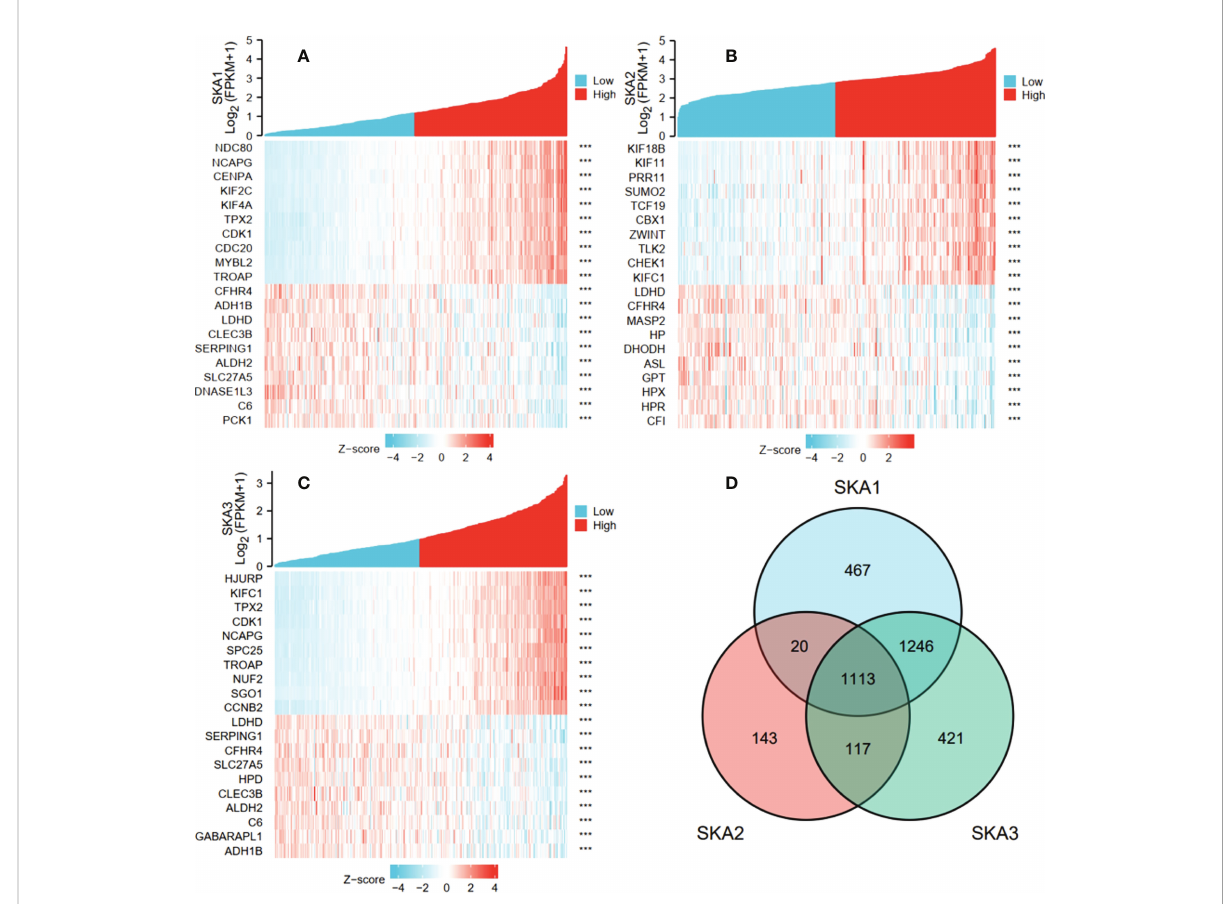
FIGURE 6 The top 10 genes with positive and negative co-expression of SKA1 (A) , SKA2 (B) , SKA3 (C) in TCGA database according to Heat map and Venn map. (D) Intersection co-expression genes of SKA1/2/3. Note: |r| >0.4 and P<0.001. SKA, spindle and kinetochore associated.